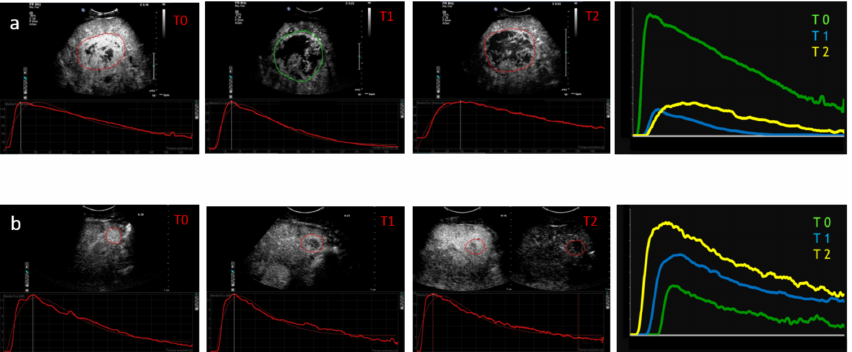
Figure 4. Two examples of HCC patients undergoing systemic therapy. ( a ) Contrast-enhanced ultrasound with the corresponding time–intensity curve at baseline (T0). At 15 (T1) and 30 days (T2) after the onset of sorafenib therapy, CEUS revealed an increase in tumor necrosis with a drastic reduction in tumor perfusion parameters, as shown by the contrast enhancement pattern and the corresponding time-intensity curve. Time–intensity curves of tumor enhancement are shown at baseline (green curve), on day 15 (blue curve), and on day 30 (yellow curve). It is possible to observe a reduced maximum enhancement and lower area under the enhancement curve early after treatment. Intensity is measured in absolute intensity units (AIU) on the ordinate, while time is measured on the abscissa (in seconds). ( b ) Contrast-enhanced ultrasound images and the corresponding time intensity curves of HCC lesion before and after treatment with sorafenib are shown in a non-responder patient. The CEUS and the corresponding time–intensity curves of tumor enhancement show no significant difference in perfusion parameters at baseline (T0, green curve), on day 15 (T1, blue curve), or on day 30 (T 2, yellow curve). Intensity is measured in absolute intensity units (AIU) on the ordinate, while time is measured on the abscissa (in